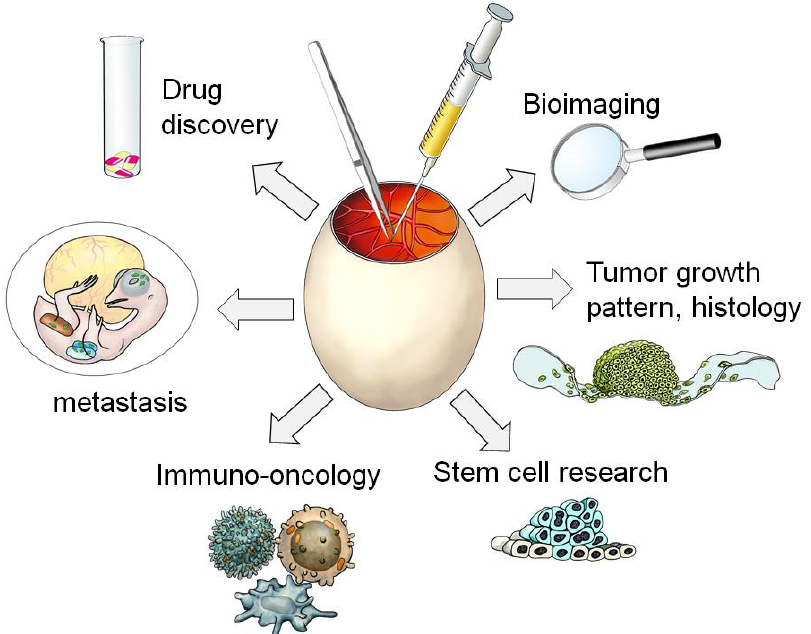
Figure 1. The huge panel of applications for the CAM model [thanks to Jörg Pekarsky (Institute of Functional and Clinical Anatomy, Friedrich Alexander University Erlangen-Nürnberg) for his help with this self-made artwork].